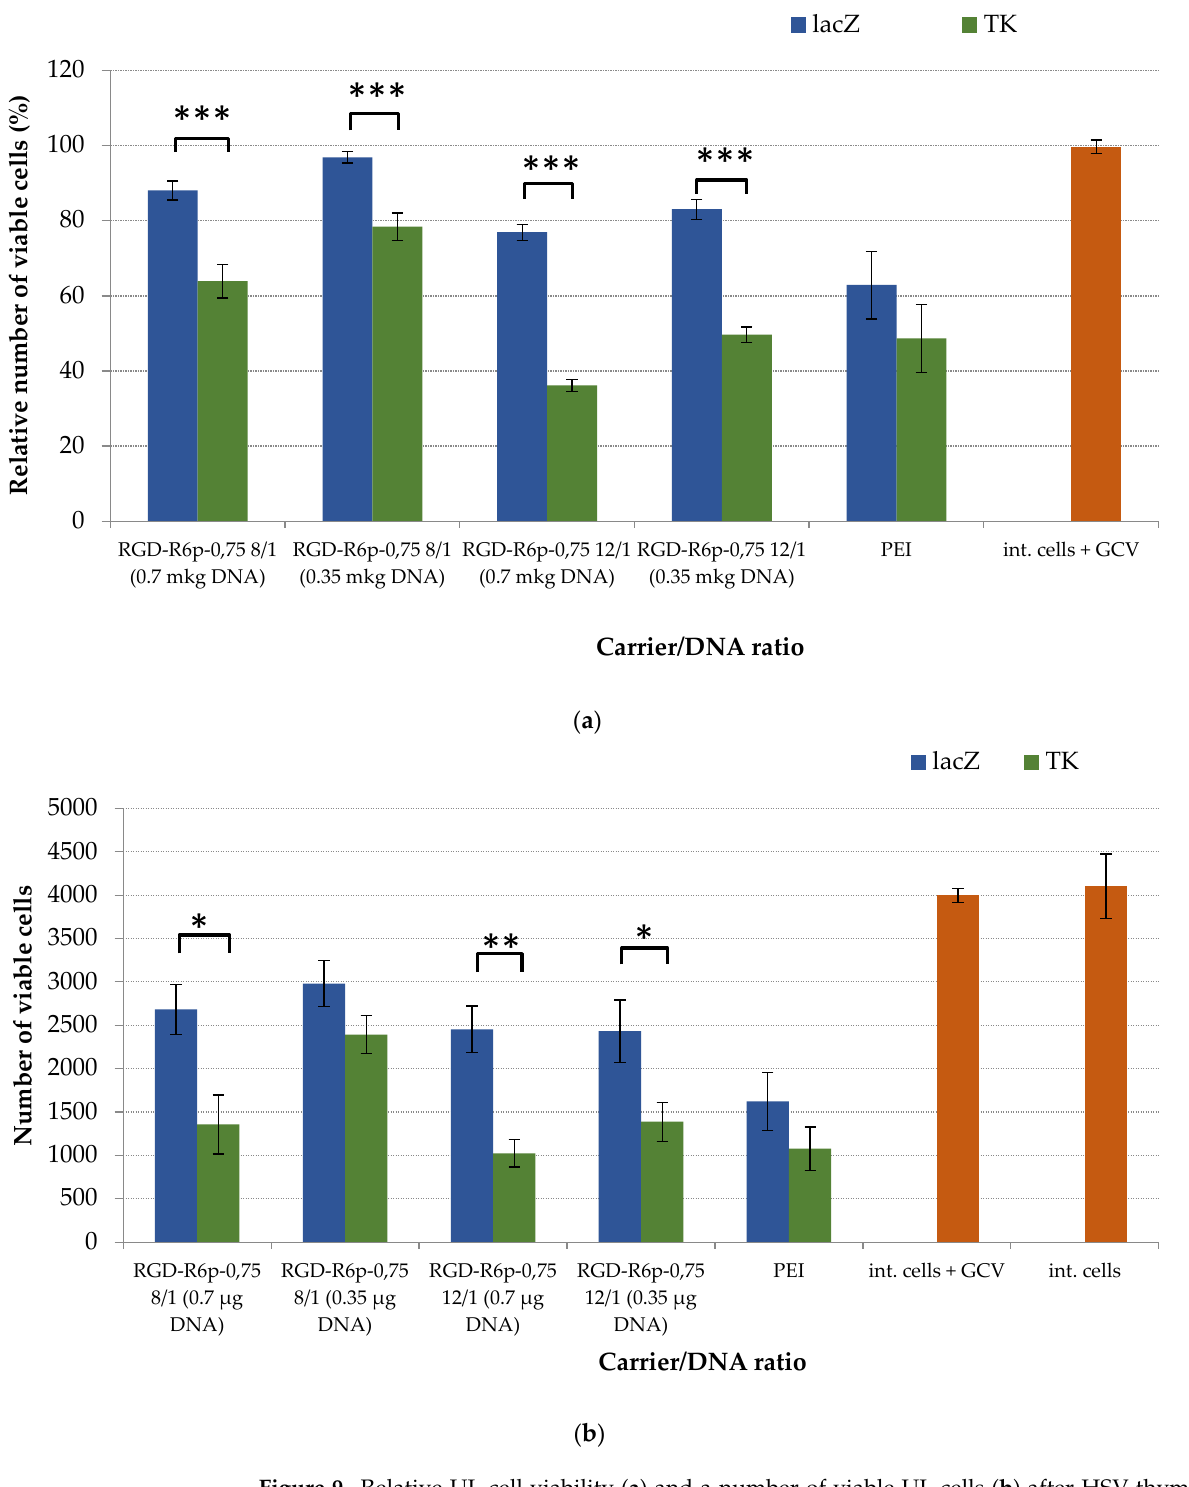
1.2–2.2-fold decrease in UL cells’ proliferative activity depending on the dose of DNA ratios.